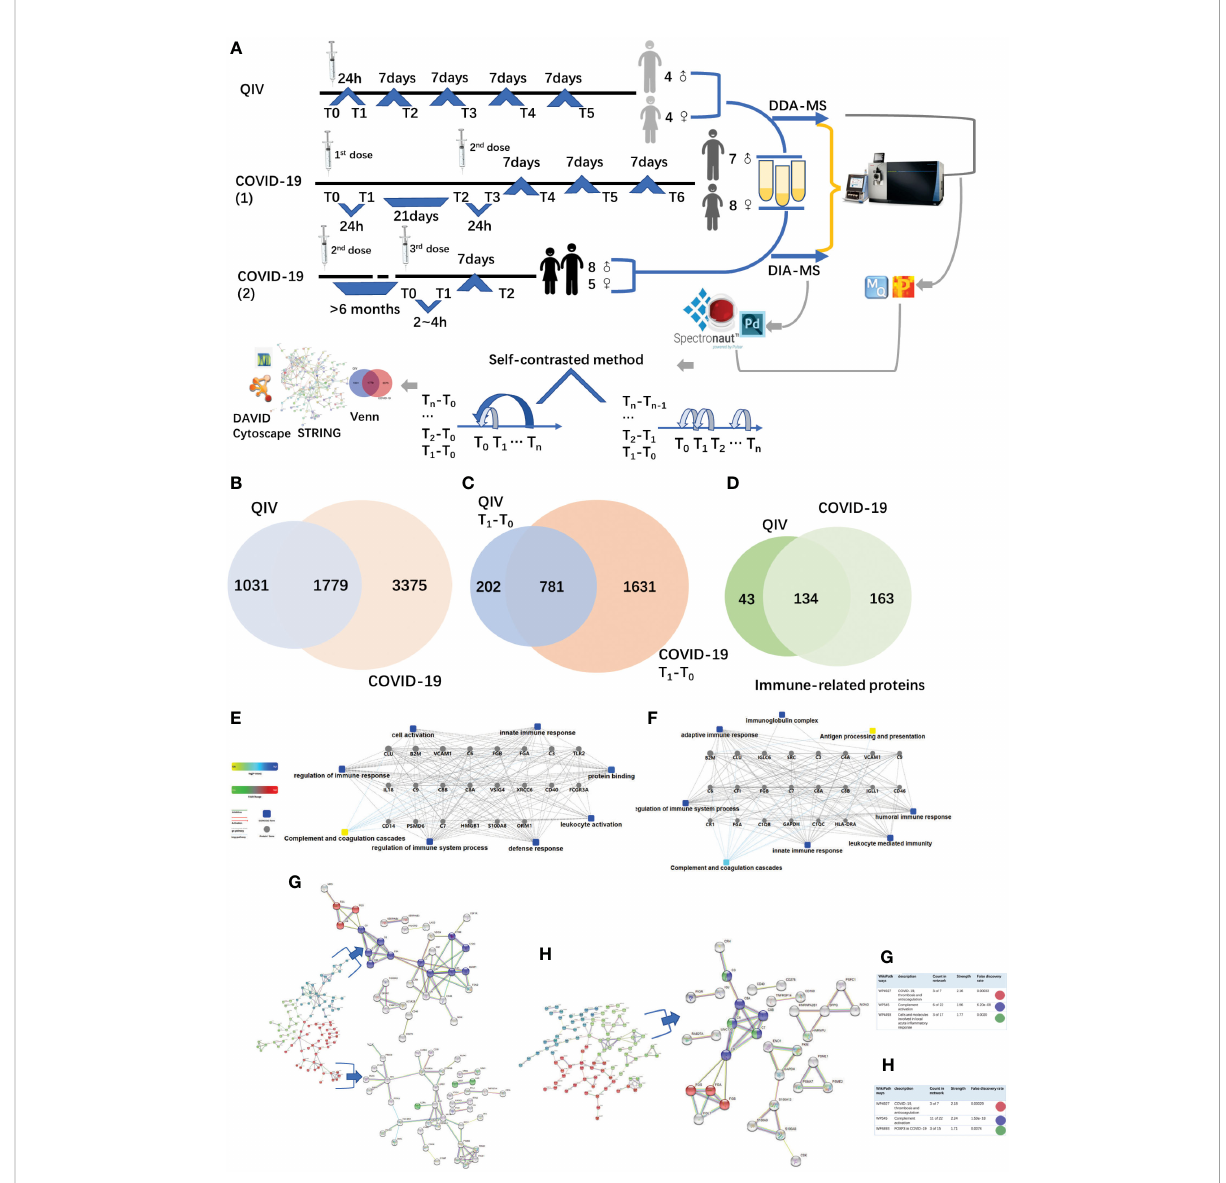
FIGURE 1 Overview of the two cohorts and the proteomic work fl ow. (A) Two cohorts and an illustration of the experimental design. A total of 170 urine samples (36 vaccines) were analyzed from QIV and COVID-19 cohorts. The data-dependent/independent acquisition(DDA/DIA) technique was applied for quantitative proteomics. Integrated data analysis involved protein expression, clustering, and functional correlational network strategies. (B) Venn diagram of total proteins in the QIV cohort compared with the COVID-19 cohort. (C) Venn diagram of differential proteins in the QIV cohort compared with the COVID-19 cohort(T 1 -T 0 ). (D) Venn diagram of immune-related proteins in the QIV cohort compared with the COVID-19 cohort. Venn diagrams show the overlaps between total, differential(T 1 -T 0 ), and immune-related proteins. (E, F) The interaction diagrams of immune-related proteins of QIV cohort and COVID-19 cohort respectively involved in tight junctions. Square box represents GO/ KEGG pathways, the signi fi cance of the pathways represented by − log( p value) (Fisher ’ s exact test) was shown by color scales with dark blue as most signi fi cant. (G) STRING highest con fi dence(minimum required interaction score: 0.9) PPI network analysis of the immune-related proteins in QIV cohort. The average node degree is 1.13, average local clustering coef fi cient is 0.387, and PPI enrichment p -value is< 1.0e-16. (H) STRING highest con fi dence(minimum required interaction score: 0.9) PPI network analysis of the immune-related proteins in COVID-19 cohort. The average node degree is 1.41, average local clustering coef fi cient is 0.368, and PPI enrichment p-value is< 1.0e-16. The